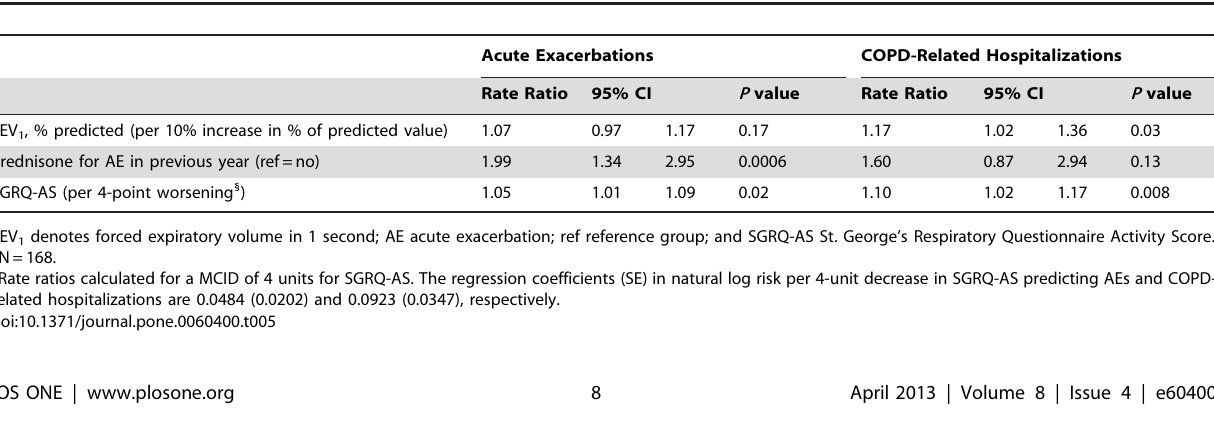
Table 5. Multivariate Model of Associations between SGRQ-AS and Number of Acute Exacerbations and COPD-Related Hospitalizations Adjusting for FEV 1 % Predicted and Prednisone for AE in Previous Year.